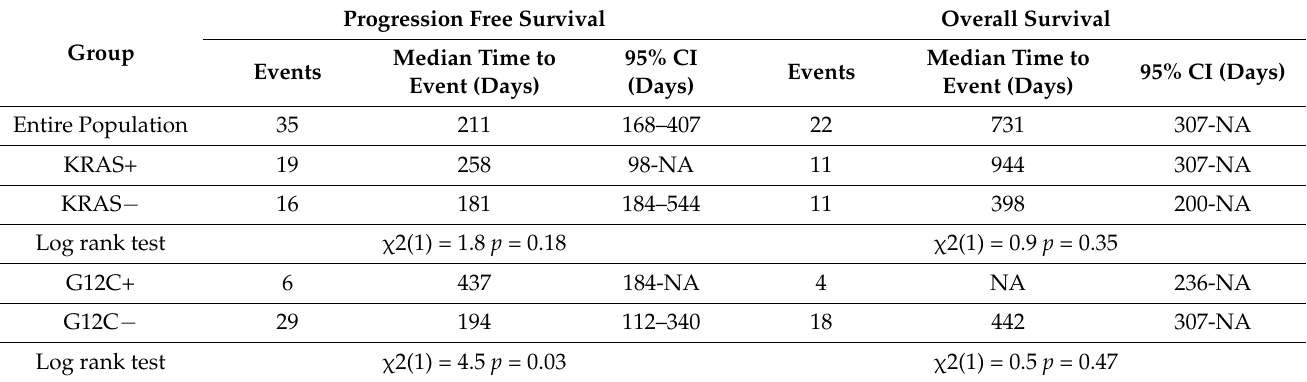
Table 2. Summary of PFS and OS Events in the Study Population. Abbreviations: G12C+, cases with G12C mutations in KRAS gene; G12C − , cases without a G12C mutation in the KRAS gene; KRAS+, patients with KRAS mutations; KRAS − , patients without KRAS mutation; mut, mutations; OS, overall survival; p , p value; PFS, progression-free